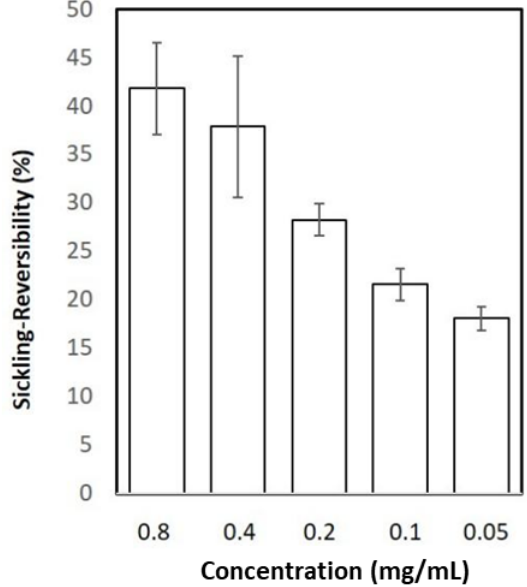
Figure 4. Reversibility effects of quercitrin on HbSS-RBC sickling in vitro, at low oxygen tension induced by Na 2 S 2 O 5 after a 5 h-incubation period. The data are represented as mean and SD, obtained from three independent experiments. The treatments all showed significant increases ( p < 0.001) in sickling reversibility over zero.